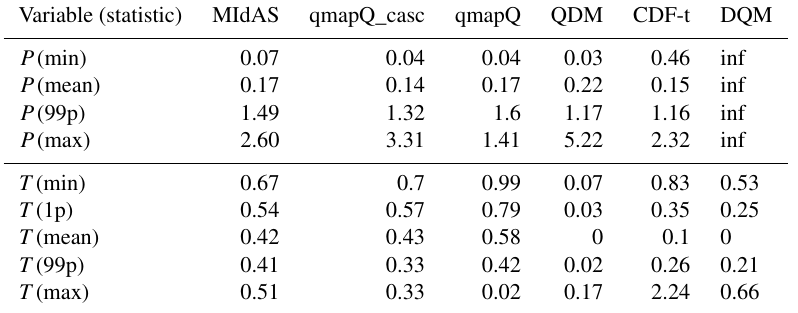
Table 4. Modulation of the climate change signal as calculated in ranking 1 across all regions, time periods, and months. Occasions where the statistic was strongly affected by outliers are marked “inf” for infinity (units are mmd − 1 for precipitation and ◦ C for temperature). Variable